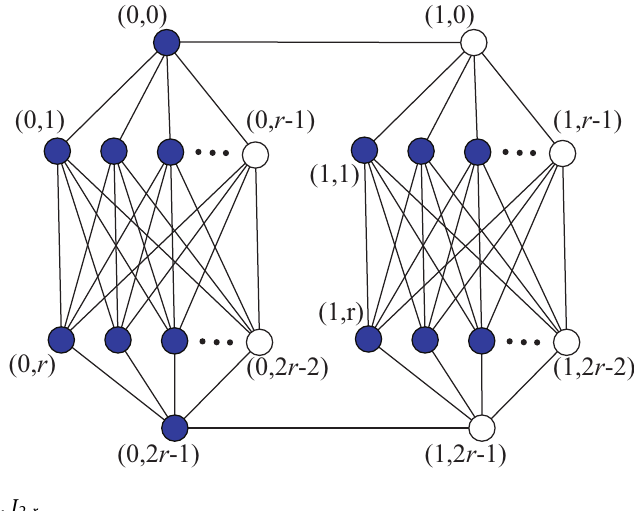
Figure 6: The double jewel, J 2,